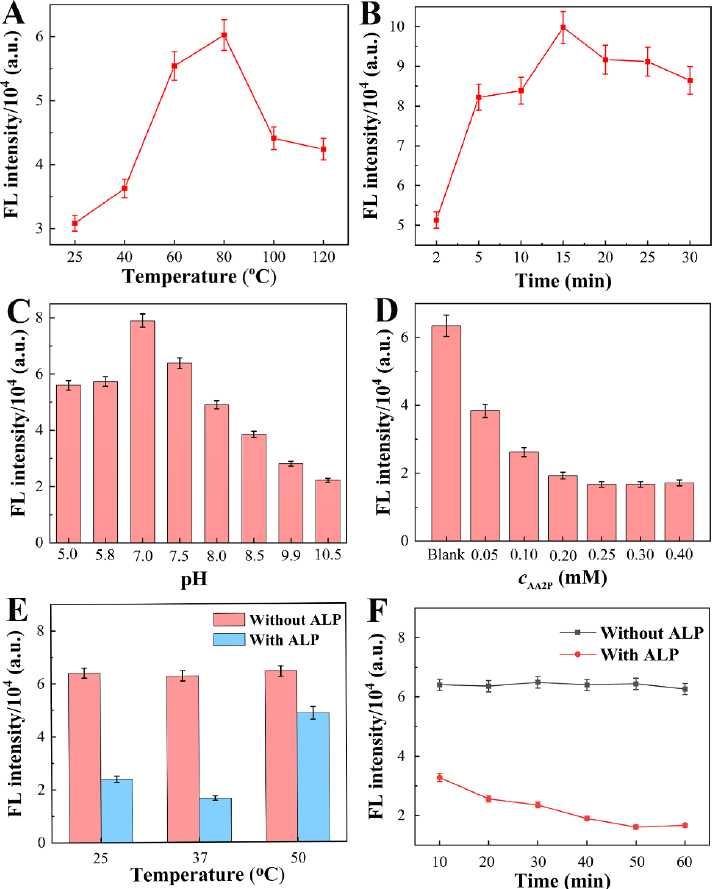
Figure 7. The effects of different microwave irradiation temperatures (25 ◦ C, 40 ◦ C, 60 ◦ C, 80 ◦ C, 100 ◦ C, 120 ◦ C) ( A ), times (2–30 min) ( B ), and pH levels (5.0–10.5) ( C ) on the fluorescent intensity of Ag-TPA CPNs. The effects of different concentrations of AA2P (0.05–0.40 mM) ( D ), reaction temperatures (25 ◦ C, 37 ◦ C, 50 ◦ C) ( E ), and times (10–60 min) ( F ) on the fluorescent detection of ALP. Note: c (ALP): 10 mU/mL; c (AA2P): 0.25 mM; Ag-TPA CPN solution: 50 μ L; λ ex : 320 nm; λ em : 490 nm; All error bars represent the standard deviation of three measurements.